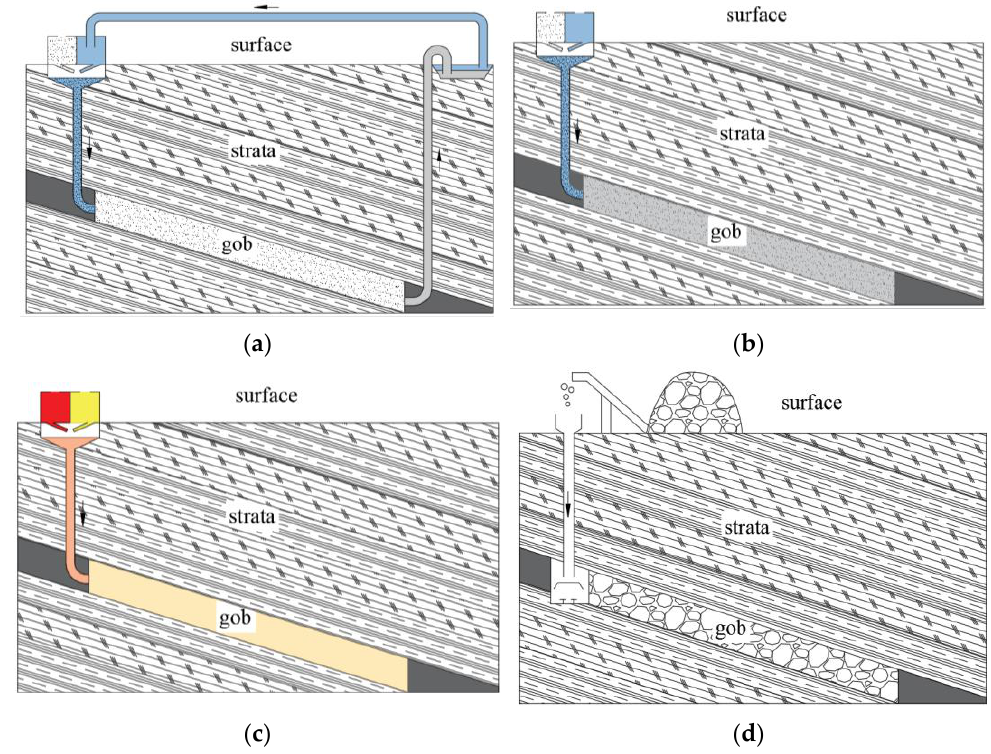
Figure 30. Transportation routes of backfilling materials under different filling methods: ( a ) hydraulic backfill; ( b ) cemented backfill; ( c ) high-water backfill; ( d ) gangue backfill.